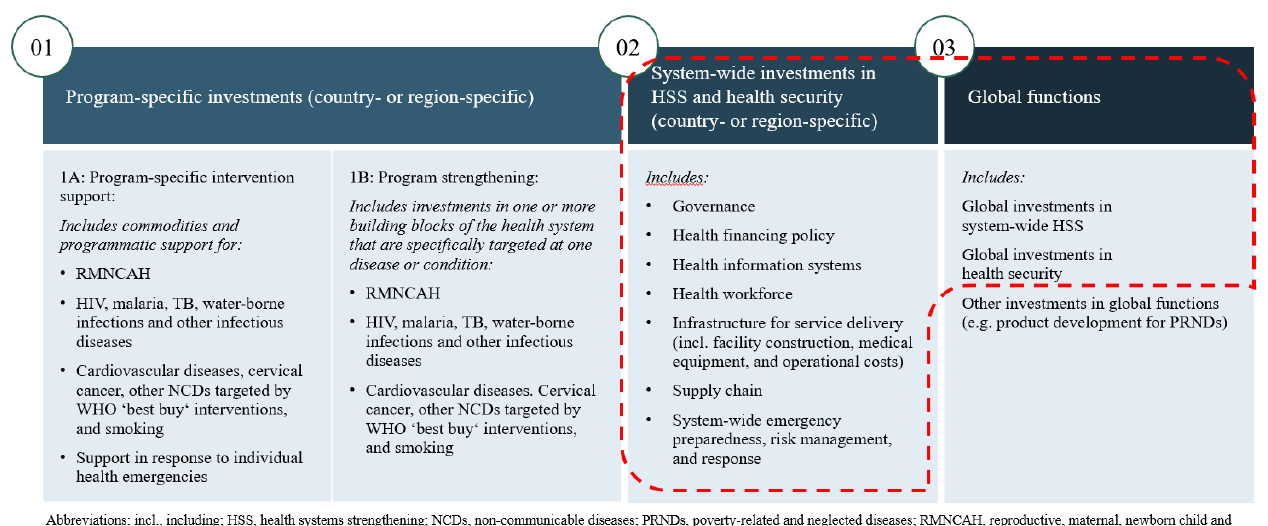
Figure 1. Analytic framework for classification of development assistance for health (DAH) into three health investment areas.